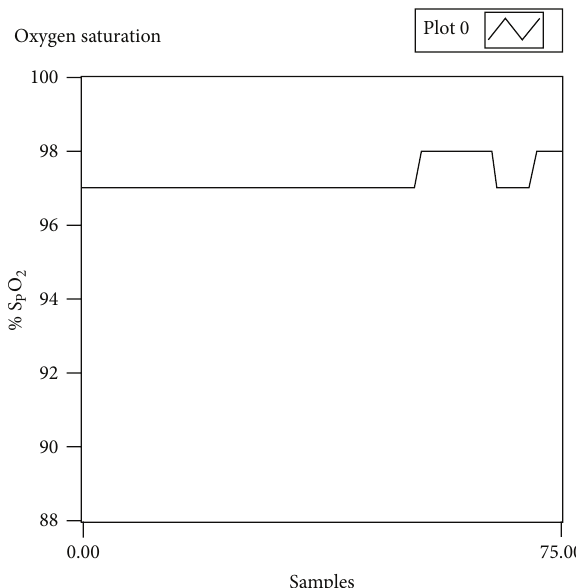
Figure 20: Oxygen saturation in the MCT for Patient 1 obtained in LabVIEW.